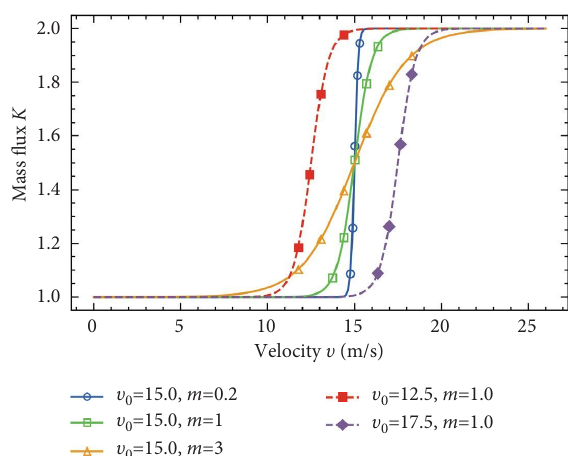
Figure 1: Smooth transition function for the mass fux parameter K